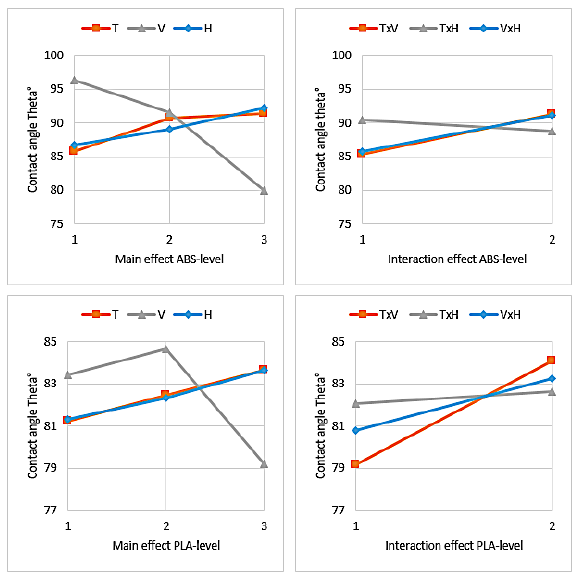
Figure 9. Main and interaction effect on